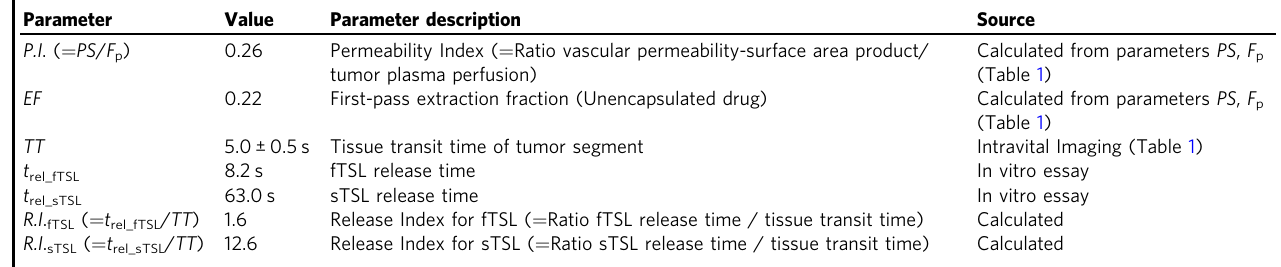
Table 2 In vivo values for key